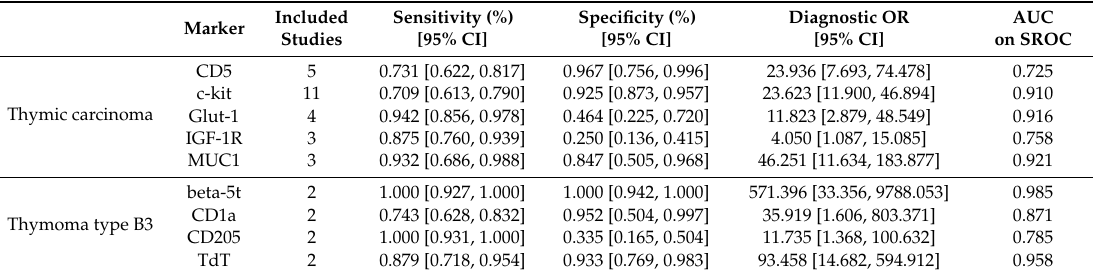
Table 4. Diagnostic test accuracy review of various immunohistochemical markers for di ff erentiation between thymic carcinoma and thymoma type